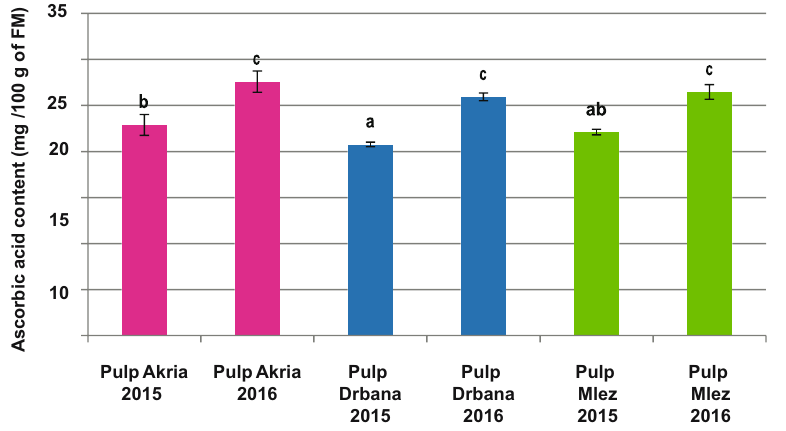
Figure 9: Ascorbic acid content of the fruit pulp of the investigated varieties ( Akria, Drbana, and Mlez ) produced in both 2015 and 2016 crop years. Average with the same letter did not reveal a signi fi cant di ff erence at p <